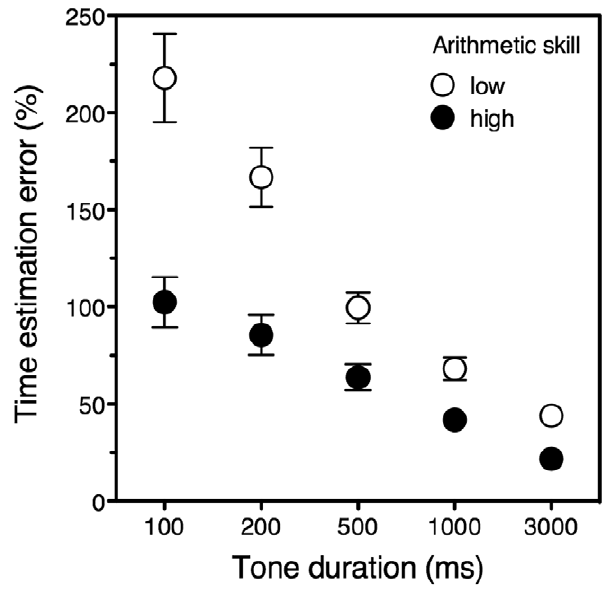
Figure 1. Time estimation error and arithmetic proficiency. Percent absolute standardized time estimation error, at five tone durations, for participants whose arithmetic score fell either in the lowest (open symbols) or highest (closed symbols) tertile. Error bars represent 6 1 standard error of the mean.